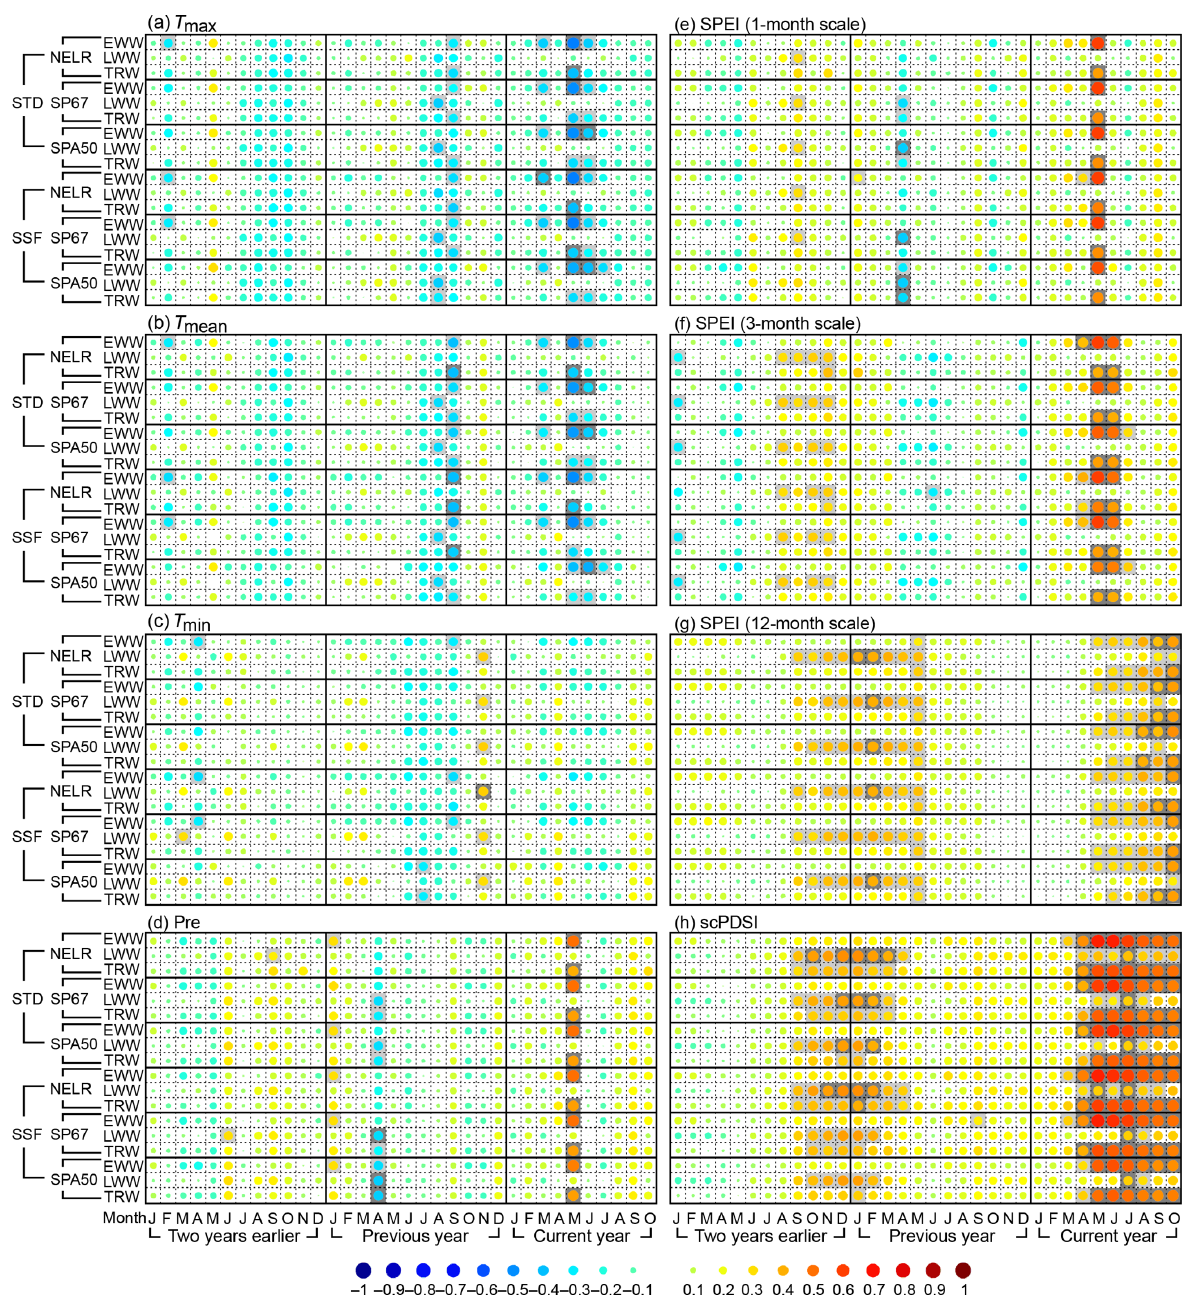
Figure 3. Matrix plots for the correlation coefficients between tree-ring-width chronologies and monthly climate time series from January of 2 years earlier to October of the current year. The climatic factors are monthly (a) maximum temperature ( T max ), (b) mean temperature ( T mean ), (c) minimum temperature ( T min ), (d) total precipitation (Pre), (e) SPEI of 1-month scale, (f) SPEI of 3-month scale, (g) SPEI of 12-month scale, and (h) scPDSI. The EWW, LWW, and TRW represent the earlywood width, latewood width, and total tree-ring width, respectively. The correlation analyses were conducted for the period 1953–2005 for the scPDSI and for 1957–2005 for the other climatic factors. NELR, SP67, and SPA50 indicate the three detrending methods: (1) negative exponential functions combined with linear regression with negative (or zero) slope (NELR), (2) cubic smoothing splines with a 50% frequency cutoff at 67% of the series length (SP67), and (3) age-dependent splines with an initial stiffness of 50 years (SPA50). STD and SSF indicate the two standardization methods “standard” and “signal-free”, respectively. The correlation coefficients are reflected by the colored and different-size circles, which can be referred to using the color bar as shown at the bottom of the figure. The squares filled with light and dark gray indicate that the correlation coefficients are statistically significant at the 0.05 and 0.01 levels, respectively, which are tested using the Monte Carlo method (Efron and Tibshirani, 1986; Macias-Fauria et al.,